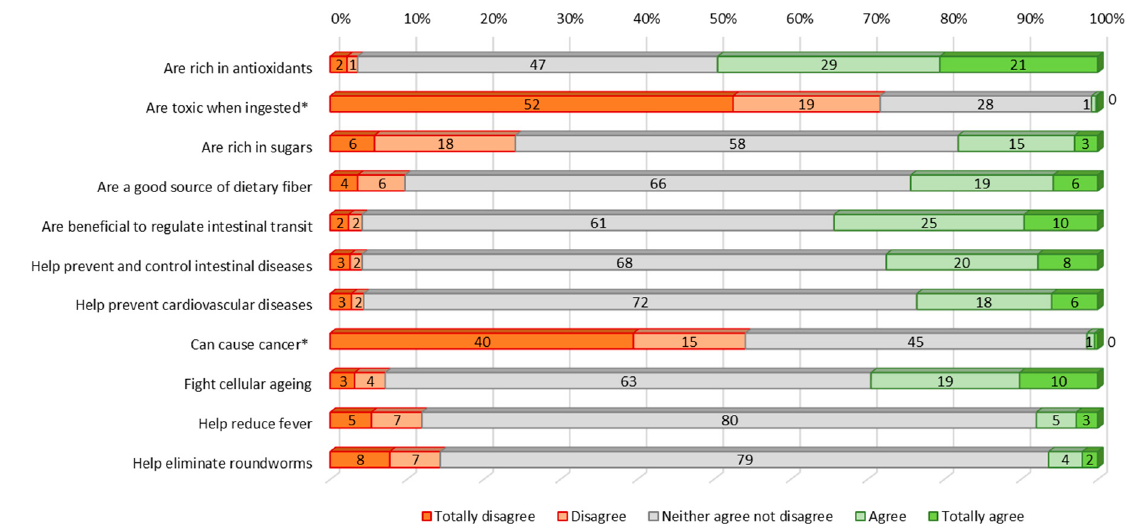
Figure 3. Level of agreement with statements related with knowledge about crowberries’ nutritional characteristics and health effects (* denotes a false statement).